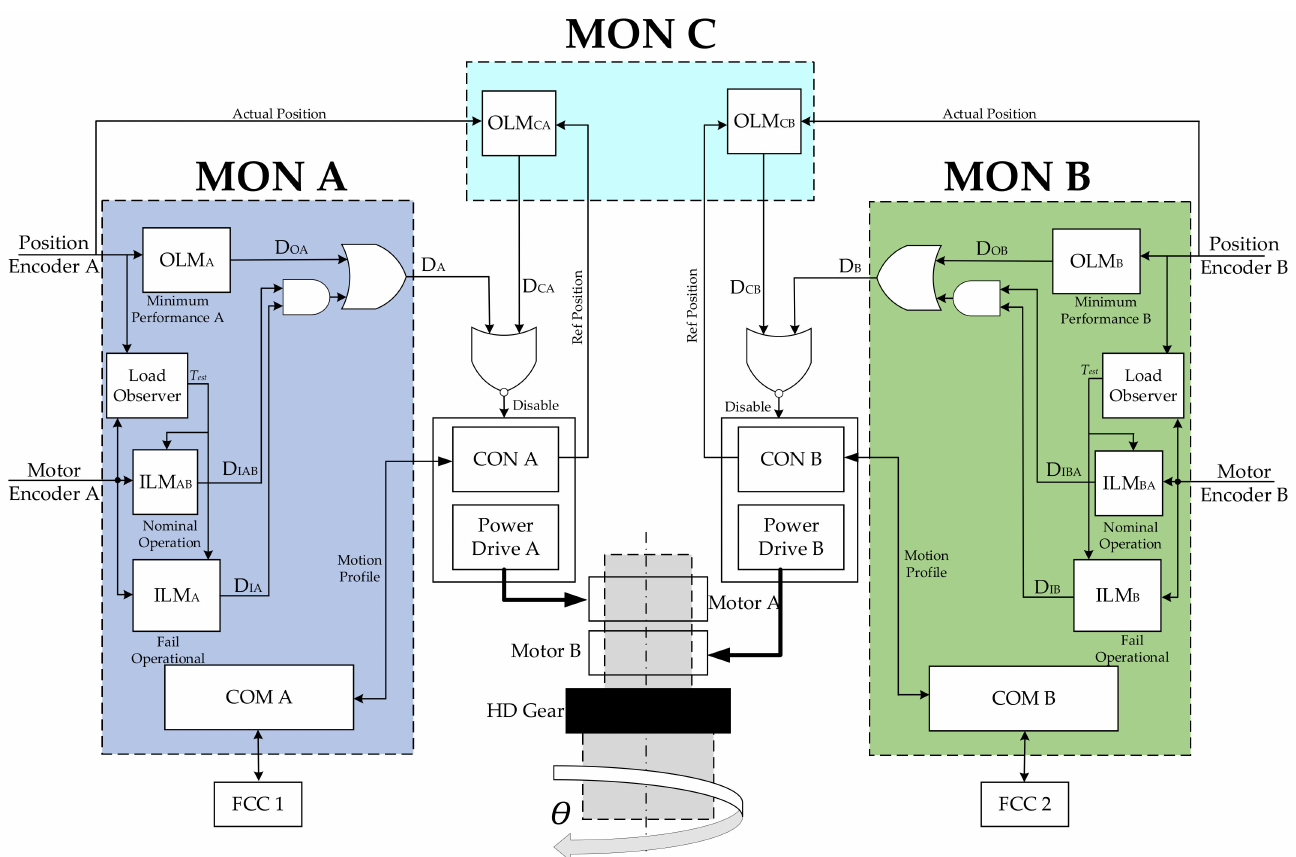
Figure 15. Fault-tolerant actuation architecture comprising three health monitoring units and a dual co-axial motor.